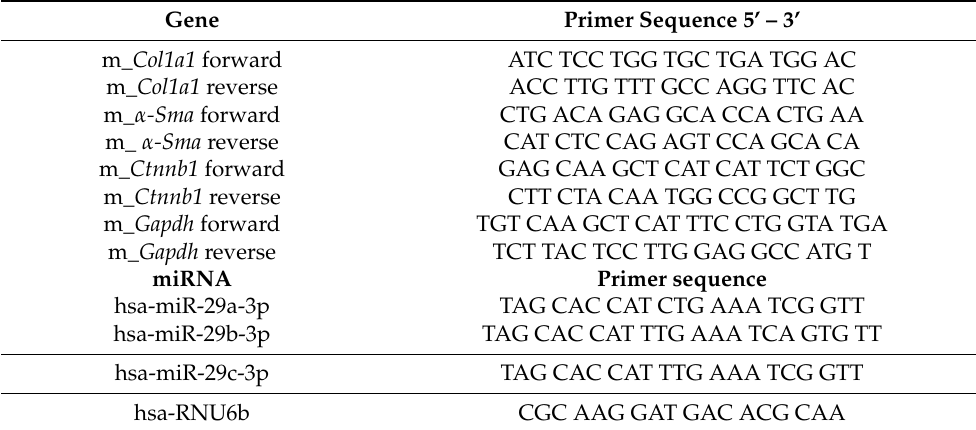
Table 1. Sequences of mRNA and miRNA primers used for qRT-PCR